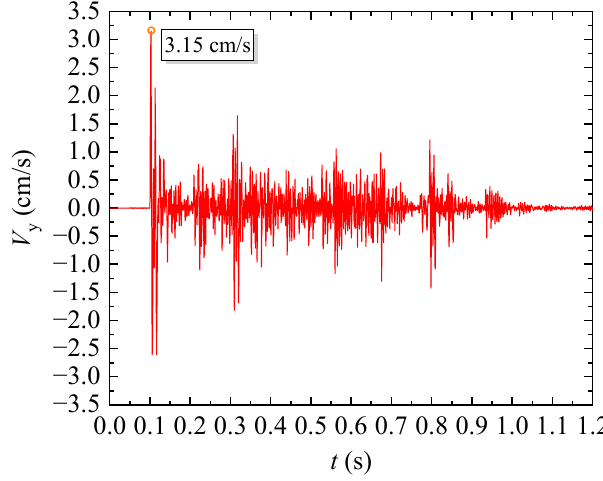
Figure 3. Vibration waveform of tunnel nonelectric detonator blasting.